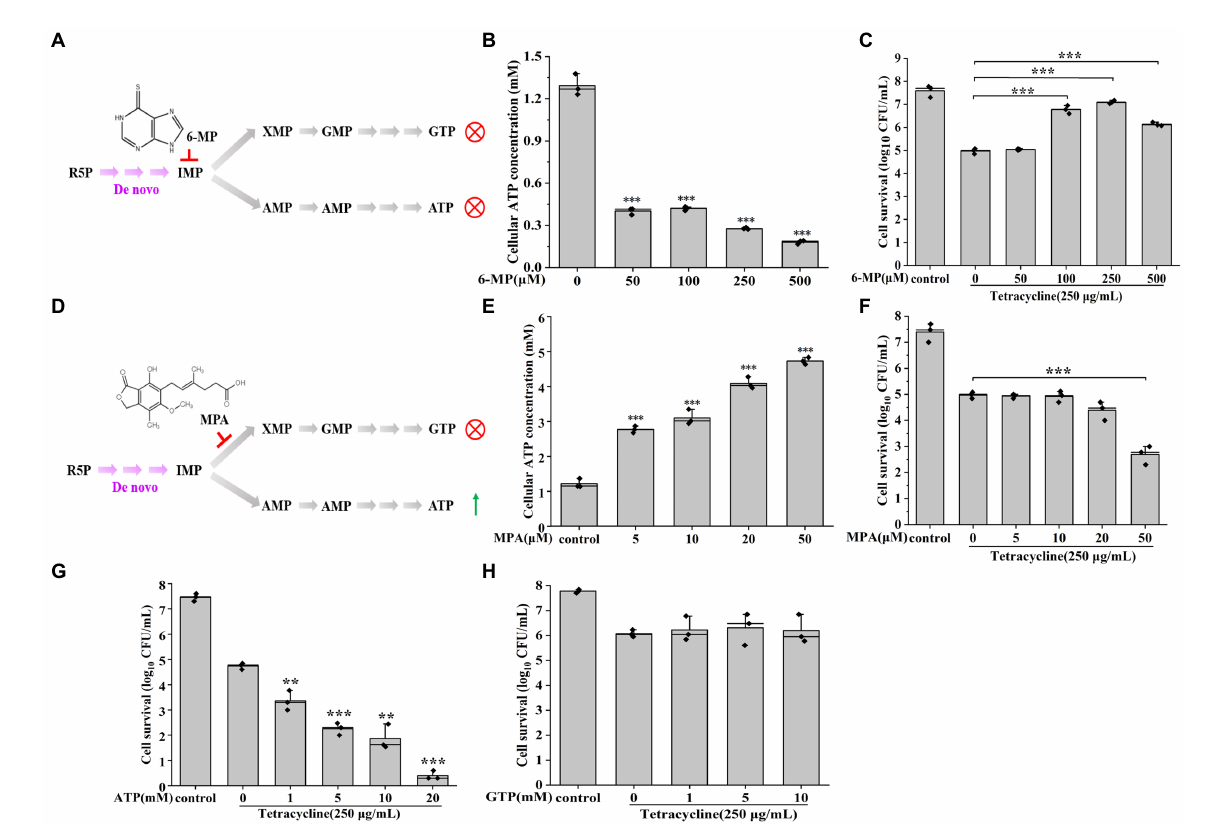
FIGURE 2 Reducing purine metabolism promotes AJ01 persistence. (A) Schematic diagram of 6-MP inhibiting ATP and GTP synthesis. R5P: Ribose 5-phosphate; IMP: inosine monophosphate; GTP: Guanosine-5 ′ -triphosphate; ATP: Adenosine triphosphate; IMPDH: Inosine-5 ′ -monophosphate dehydrogenase; HGPRT: hypoxanthine-guanine phosphoribosyltransferase; 6-MP: 6-Mercaptopurine. (B) Intracellular ATP concentration of cells treated with different concentrations of 6-MP. (C) Persister cells formation frequency after different concentrations of 6-MP treatment. (D) Schematic diagram of MPA inhibiting GTP synthesis. MPA: mycophenolic acid. (E) Intracellular ATP concentration of cells treated with different concentrations of MPA. (F) Persister cells formation frequency after different concentrations of MPA treatment. (G) Persister cells formation frequency after increasing concentrations of exogenous ATP treatment. (H) Persister cells formation frequency after increasing concentrations of exogenous GTP treatment. The bars indicated the mean of at least three independent experiments; standard deviation indicated STDEV. (* p value < 0.05; ** p value < 0.01; *** p value <